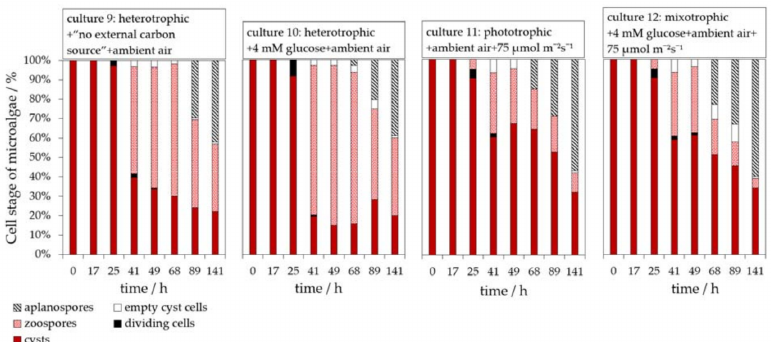
Figure 8. Relative distribution of the cell stages of H. pluvialis at different points in time after the start of germination for the heterotrophic culture 9 (heterotrophic + “no external carbon source” + ambient air) and culture 10 (heterotrophic + 4 mM glucose + ambient air), phototrophic culture 11 (phototrophic + ambient air + 75 µ mol m − 2 s − 1 ) and mixotrophic culture 12 (mixotrophic + 4 mM glucose + ambient air + 75 µ mol m − 2 s − 1 ).